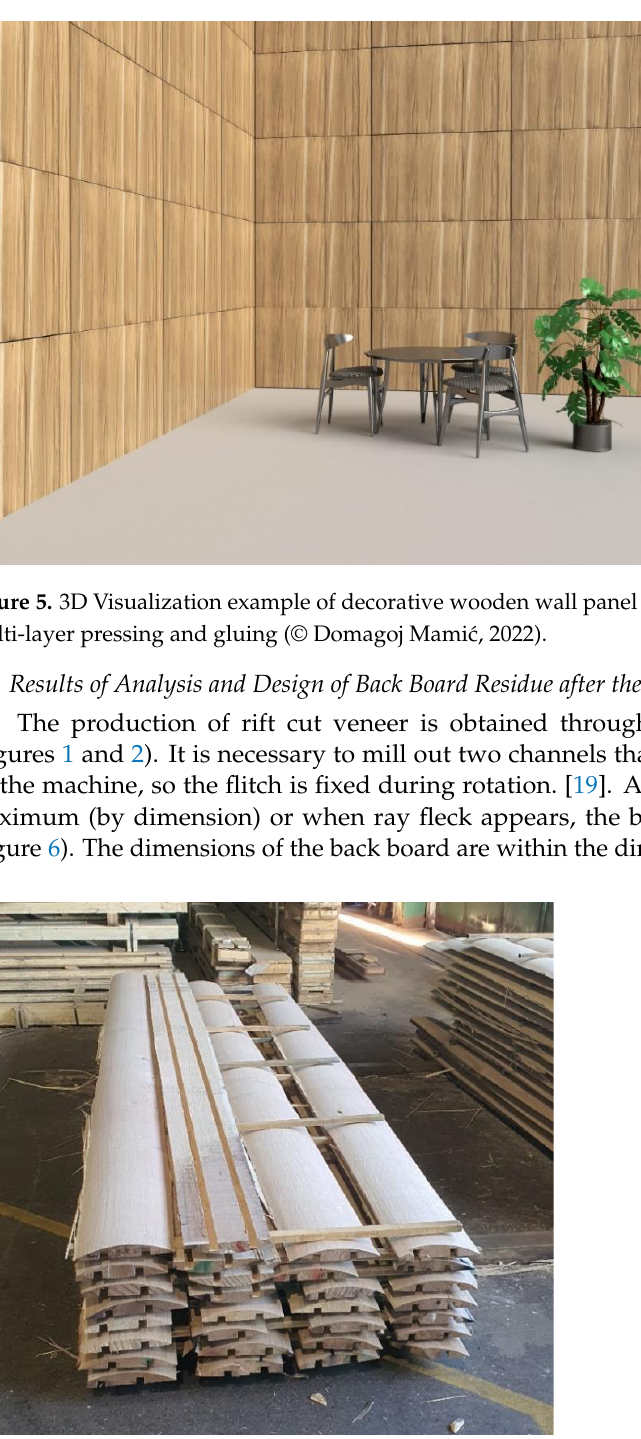
Figure 6. Back board from rift cut veneer productio n (© Domagoj Mamić, 2021).